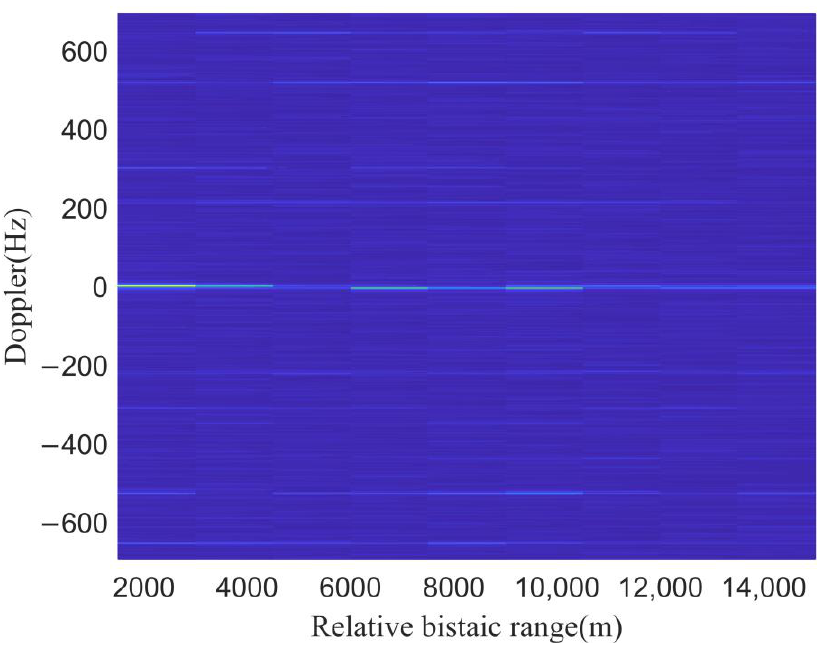
Figure 15. The RDCC result of the original signal.